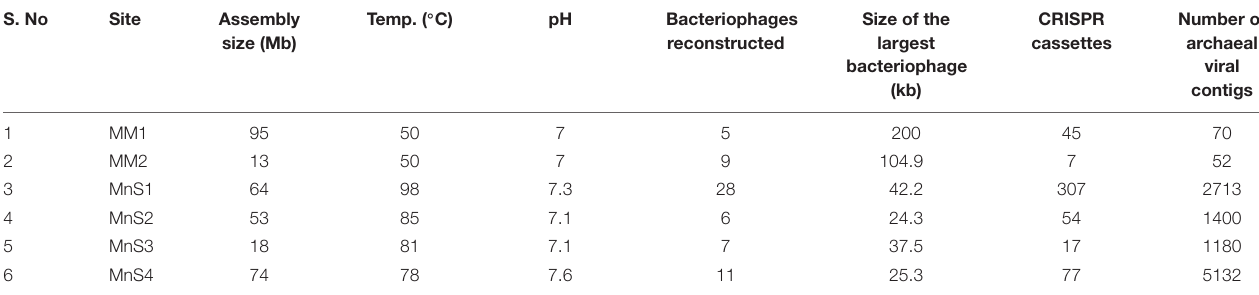
TABLE 1 | Characteristics of the metagenome samples analyzed from the Manikaran hot springs. S.